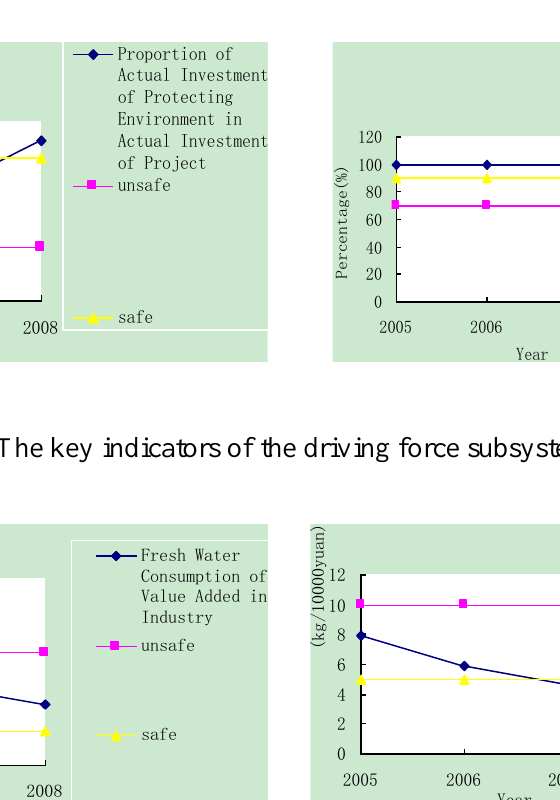
Figure 5. The variation of the key indicators of each subsystem during